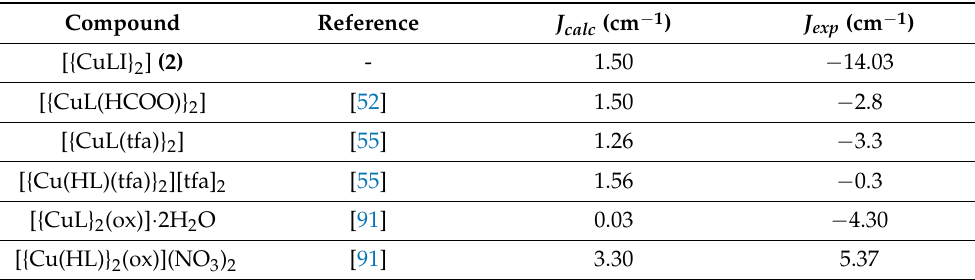
Table 5. Experimental ( J exp ) and calculated ( J calc ) J -values, H = − 2JS 1 S 2 , using the Broken Symmetry Approach of the Exchange Coupling